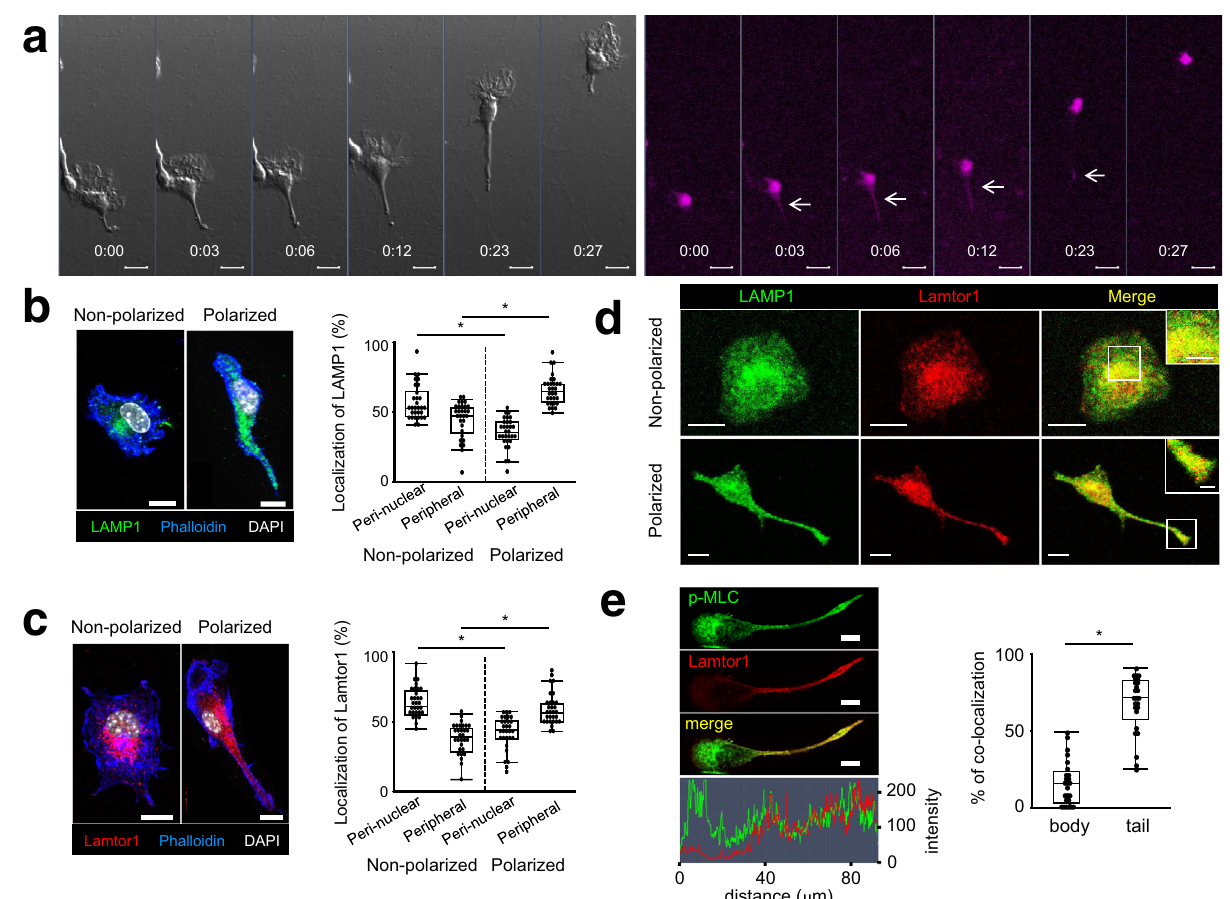
Fig. 1 Localization of the lysosome and Lamtor1 to the rear of migrating DCs. a Localization of lysosomes during DC migration in a con fi ned 3D environment. BMDCs were labeled with 1 μ M AcidiFluor ORANGE and stimulated with LPS for 2h. Movement of DCs (left) and AcidiFluor-positive lysosomes (magenta) in response to CCL19 (5 μ g/ml) in type I collagen gel (2mg/ml) in a Zigmond chamber were observed at 1-min intervals by time-lapse video imaging. b , c Localization of LAMP1 + lysosomes ( b ) and Lamtor1 ( c ) in non-polarized and polarized DCs. WT DCs were stained with anti-LAMP1 (green) ( b ), anti-Lamtor1 (red) ( c ), phalloidin (blue), and DAPI (white), and then visualized by confocal microscopy. Polarized and non-polarized cells were identi fi ed morphologically. Representative images are shown. Scale bar, 10 μ m (left). The percentages of the ROI in the perinuclear and peripheral regions were determined ( n = 30) (right). The perinuclear region was de fi ned as the region within 5 μ m of the nuclear membrane, and the peripheral region was de fi ned as the region of the cell outside the perinuclear region. d Co-localization of Lamtor1 and LAMP1 in non-polarized (upper) and polarized (lower) DCs. DCs were stained with anti-Lamtor1 (red), anti-LAMP1 (green), and DAPI (white), and then visualized by confocal microscopy. Representative images are shown. Scale bar, 10 μ m. Data are representative of three experiments. e Co-localization of Lamtor1 and phosphorylated MLC. Lamtor1 and phosphorylated MLC were visualized by staining in THP1 expressing Lamtor1-FLAG (red) with anti-p-MLC (green). Representative confocal images of polarized cells (left); scale bar, 10 μ m (upper). Intensities of Lamtor1 (red) and p-MLC (green) (lower). Percentage of co-localization of Lamtor1 and p-MLC in body or tail region of polarized cells ( n = 25 cells) (right). Data are representative of three experiments. Statistical analyses were performed by two-sided Steel – Dwass test ( b , c ) or Mann – Whitney U test ( e ) [median; 25th and 75th percentiles; and minimum and maximum of a population excluding outliers; *p